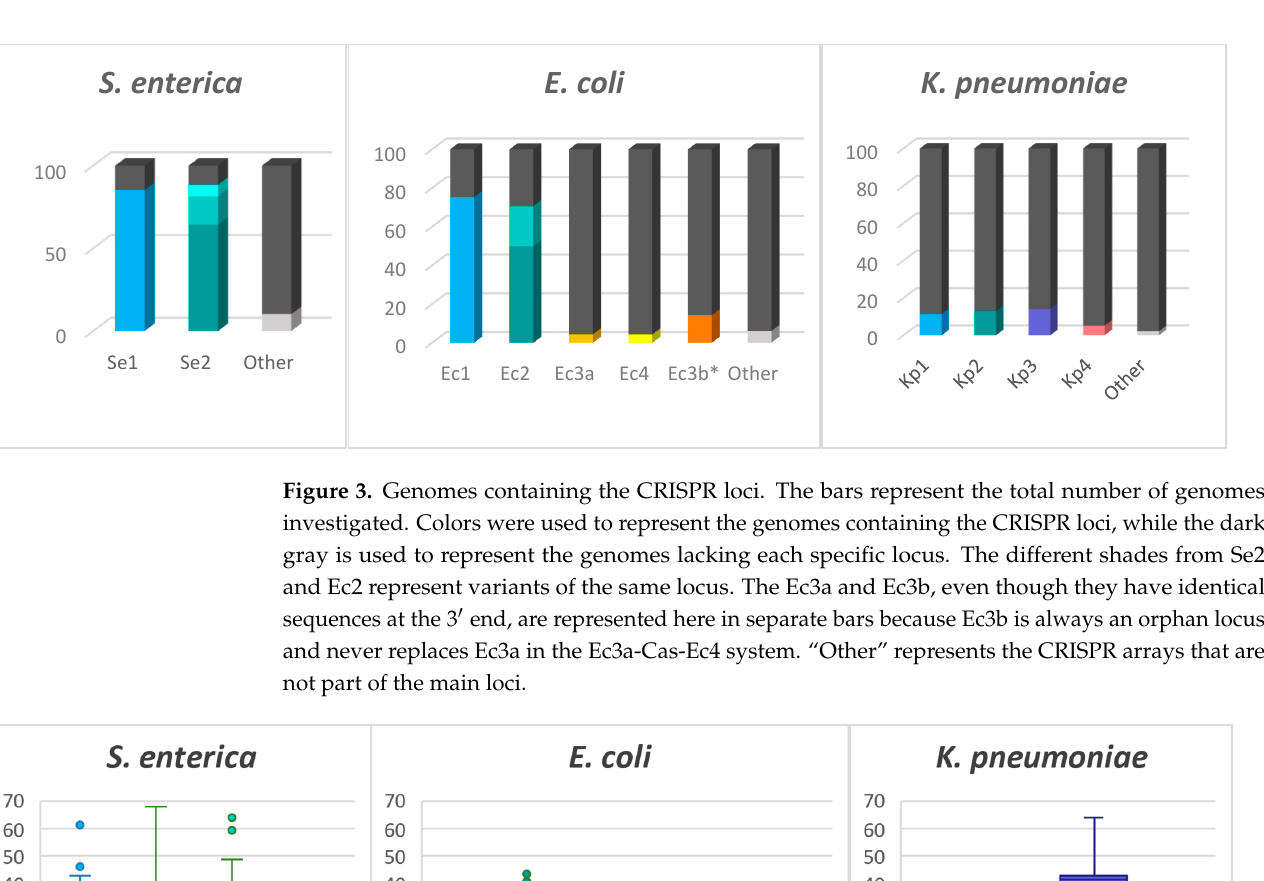
resents the CRISPR arrays that are not part of the main loci.